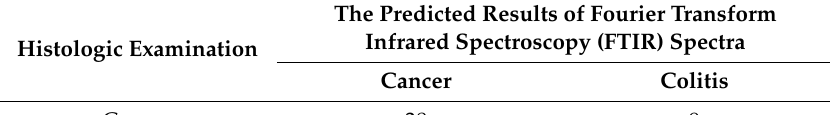
Table 2. The average of predict results of colorectal tissues with entropy weight local-hyperplane k-nearest neighbor (EWHK).